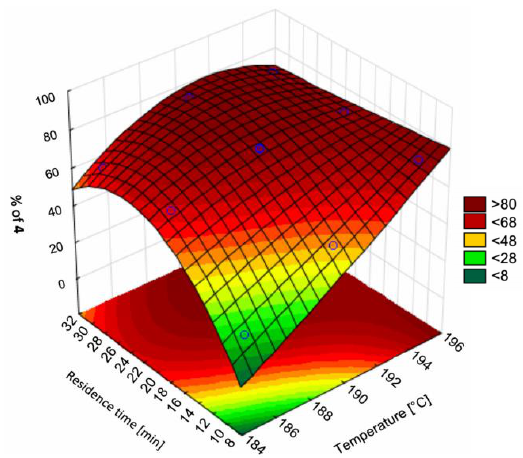
Figure 3. Reaction optimization for vortioxetine synthesis. Reproduced with permission from Boros et al., Journal of Flow Chemistry; published by Springer Nature, 2019 [54].